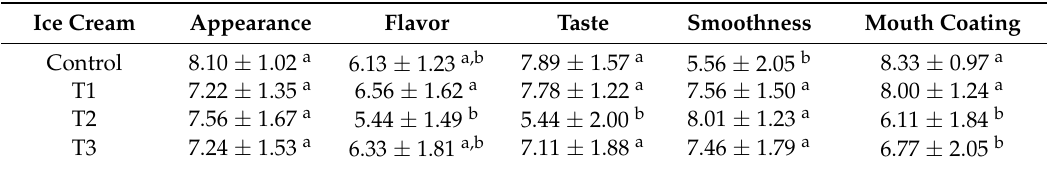
Table 3. The score of each attributes of ice cream.